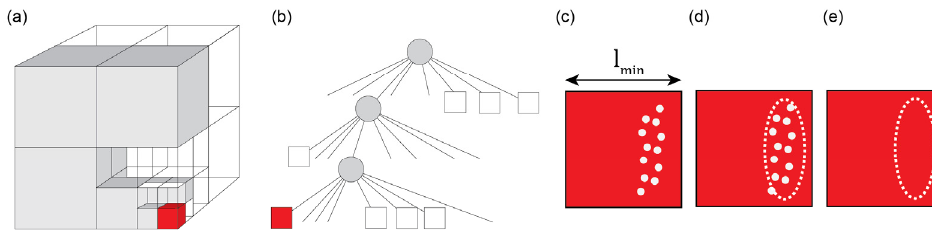
Figure 2. Schematic of a volumetric ( a ) and tree ( b ) representation of an octree structure storing Boolean occupancy free (white) and occupied (grey). Example of an occupied voxel of size l min storing MLS points of a surface ( c ), a graphical representation of the covariance of the points ( d ), and the data maintained in our octree ( e ).